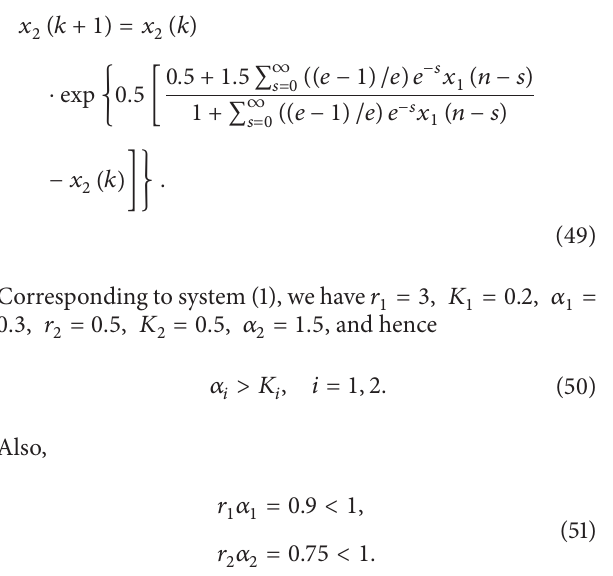
Figure1:Dynamicbehaviorsofthesolution (𝑥 1 (𝑛),𝑥 2 (𝑛)) ofsystem (49), with the initial conditions (𝑥 1 (𝑠),𝑥 2 (𝑠)) = (0.8, 0.4) , (0.5, 0.5) , and (1.5, 1.5) , 𝑠 = ⋅⋅⋅ , −𝑛,−𝑛 + 1,...,−1,0 , respectively.